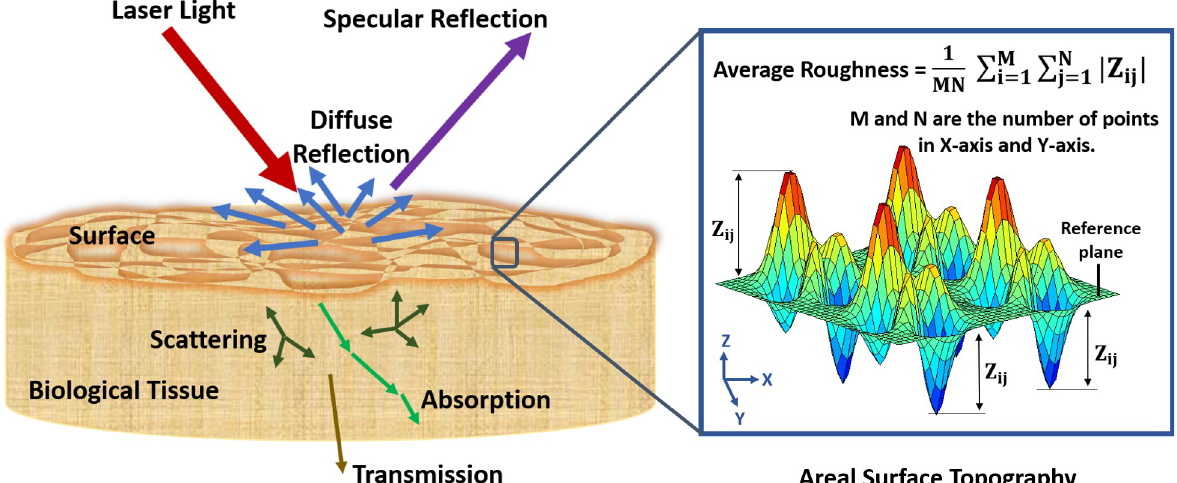
Fig 1. Shematic presentation of laser interaction with biological